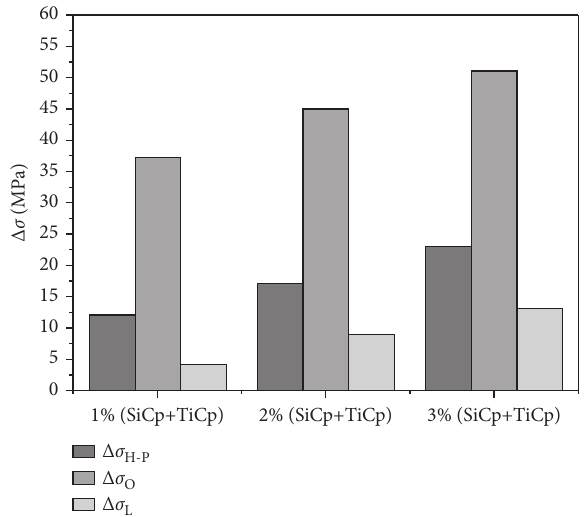
Figure 9: The contribution of different strengthening mechanisms to the YS of